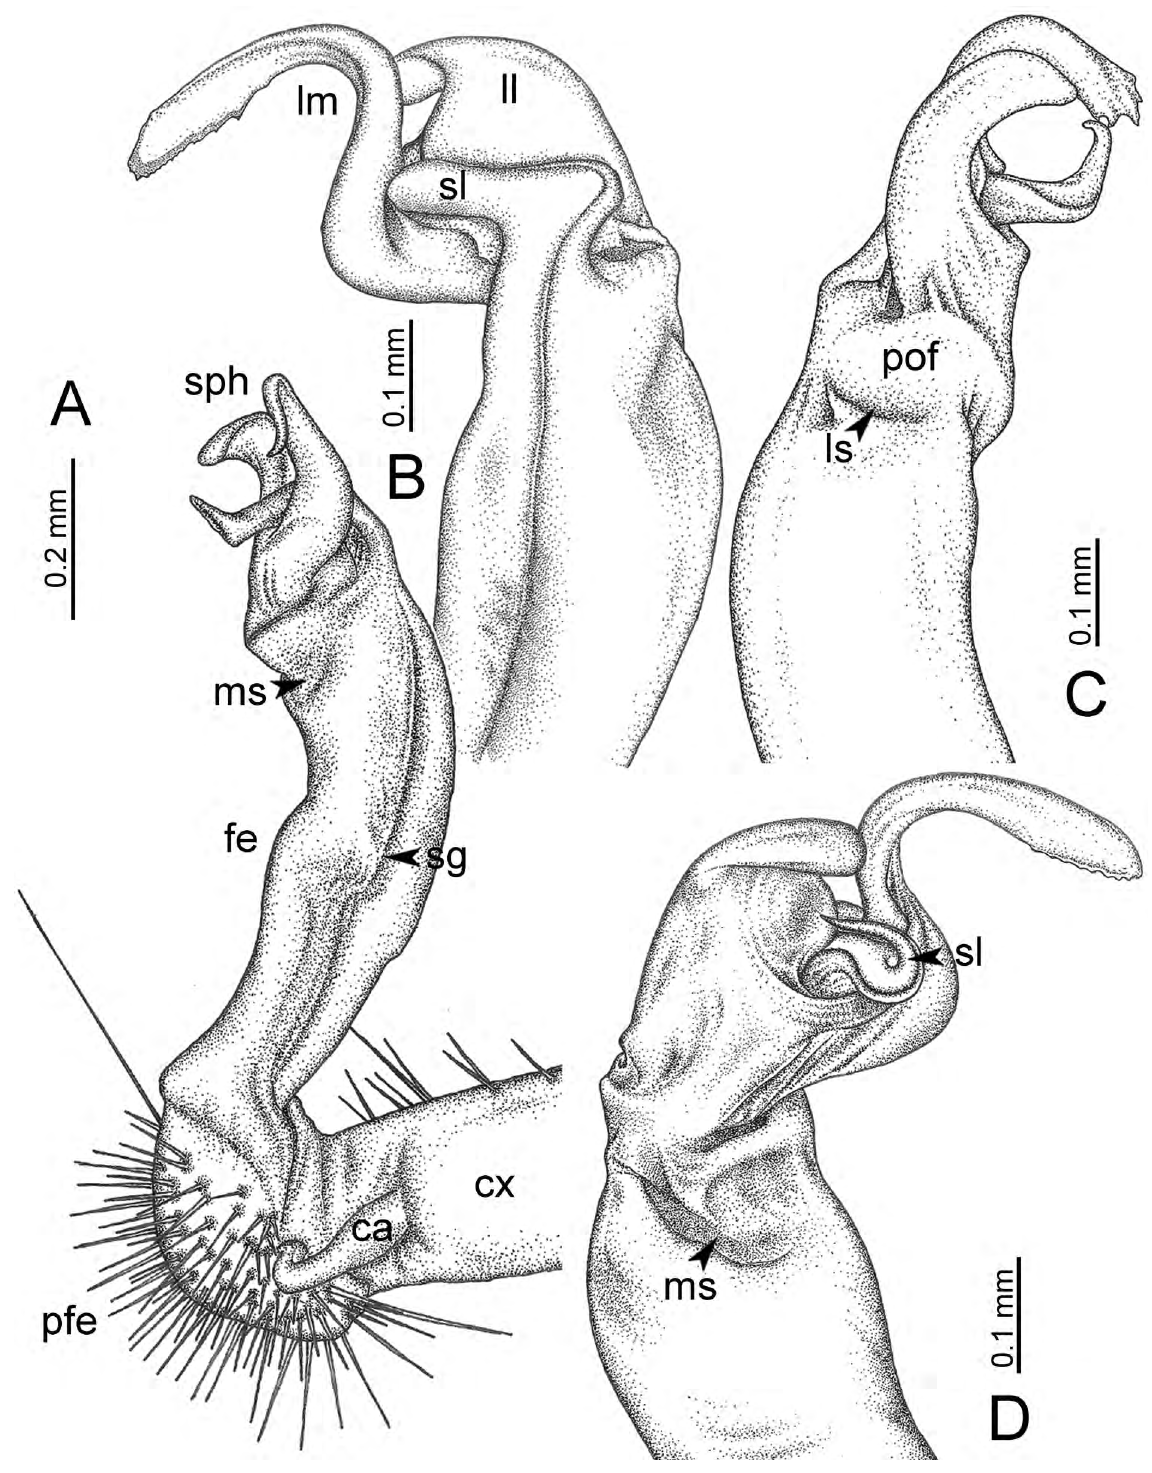
Fig. 20. Nagaxytes gracilis Srisonchai, Enghoff & Panha gen. et sp. nov., paratype (CUMZ-pxDGT00092), right gonopod. A . Mesal view. B . Dorsal view. C . Lateral view. D . Ventral